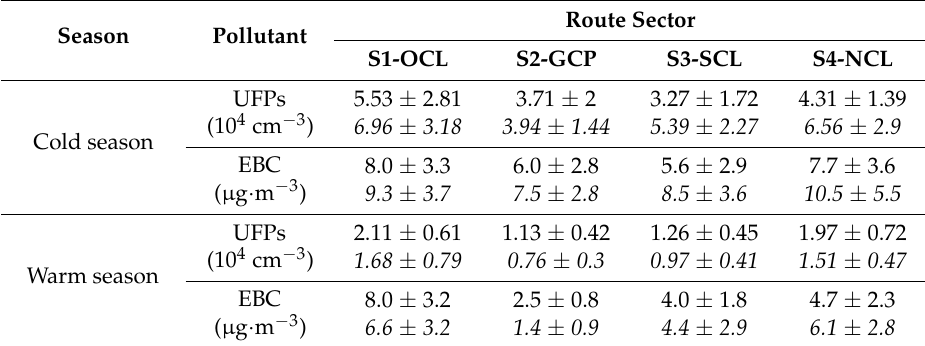
Figure 6. Box-plots of 1-min concentration data for EBC in the warm season (mean values: dots; min-max range: whiskers: median and interquartile range: boxes). Table 2. Mean and standard deviations of morning and evening (italic type) concentration data for UFP and EBC by route sector.